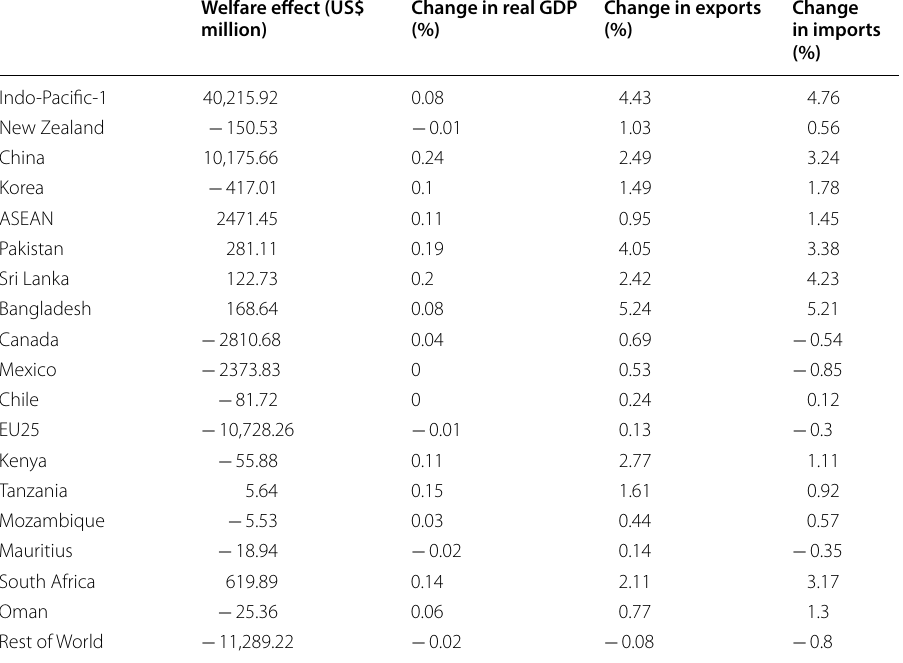
Table 10 Macroeconomic impact of tariff elimination under ‘Indo-Pacific 4’. Source: Authors’ simulation from GTAP version 9